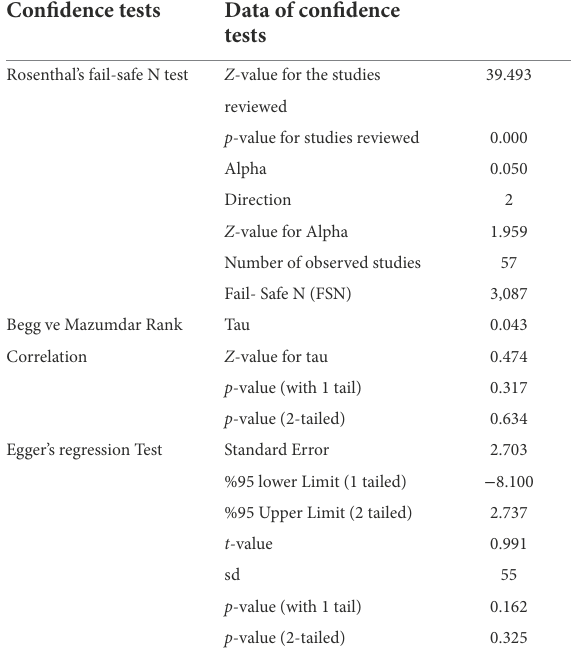
TABLE 3 Confidence tests and results showing the bias of studies included in the